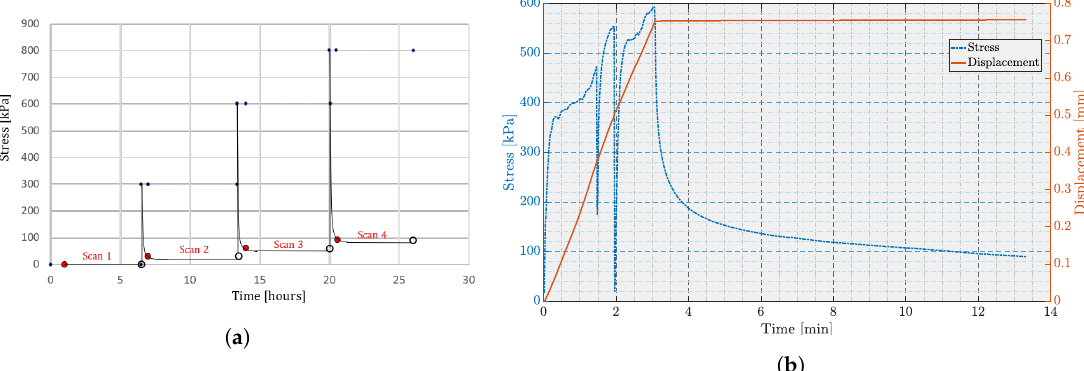
Figure 2. Graphical representation of compression tests: ( a ) schematic representation of the applied loading profile; ( b ) real-time force and displacement data for 0.6 MPa loading profile. In Figure 2a, red circles represent the beginning of scanning, white circles represent the end of scanning and blue circles represent the relaxation time during respective load